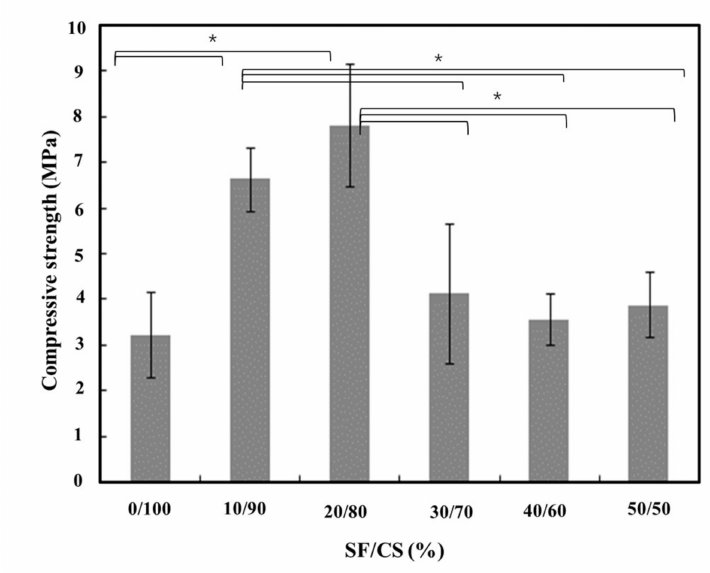
Figure 5. Compressive strength of various hydrated SF/CS cement composites (* represents p value <